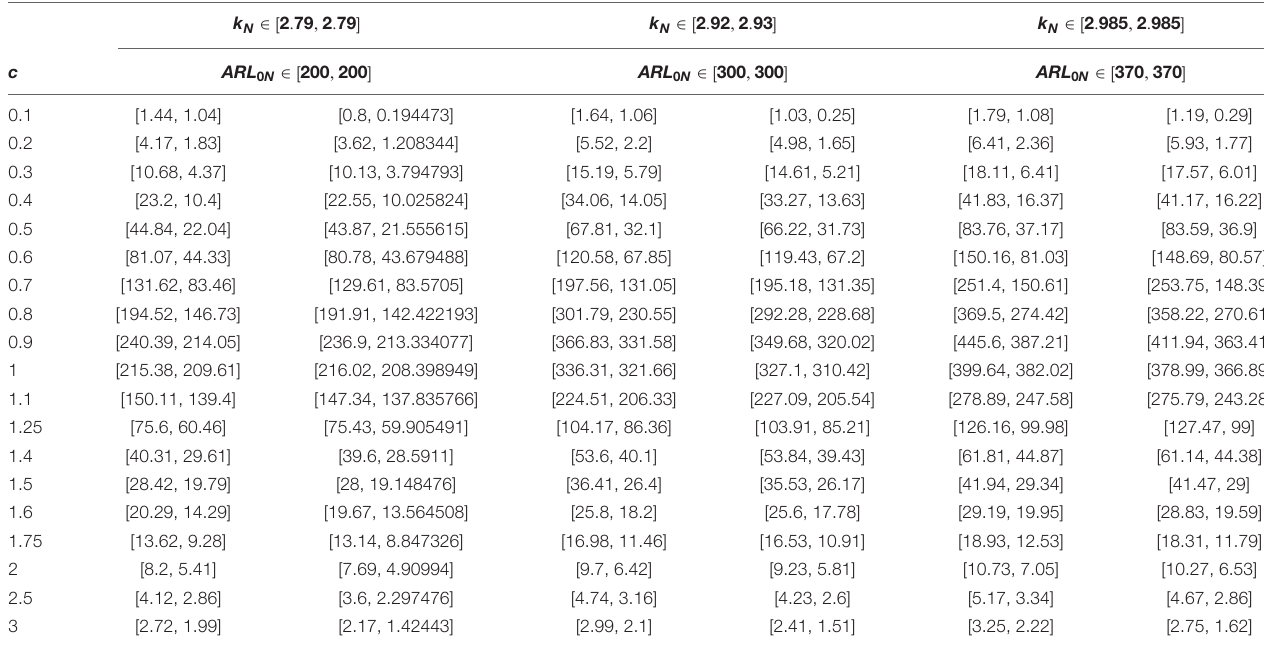
FIGURE 1 | The control charts for simulated data. TABLE 4 | The values of NARL when n N ∈ [4 , 6] and w N ∈ [1 ,